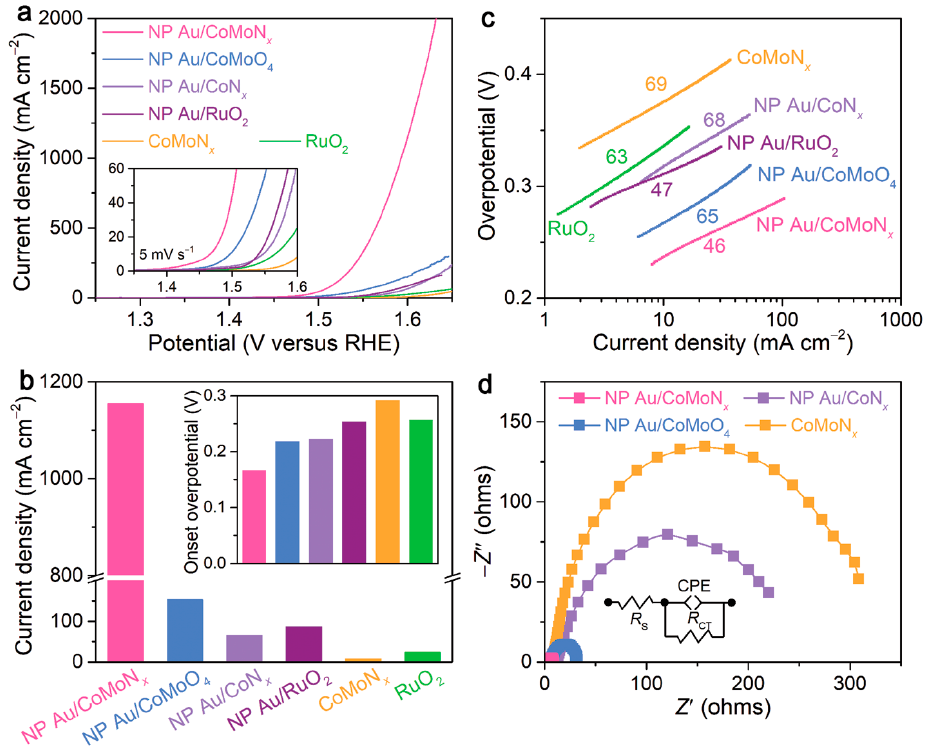
Figure 4. OER activity of bimetallic cobalt-molybdenum nitride nanosheets vertically aligned on NP-Au electrodes in alkaline media. ( a ) OER polarization curves of NP-Au/CoMoN x , Au/CoMoO 4 , Au/CoN x and Au/RuO 2 , as well as free CoMoN x nanosheets and RuO 2 immobilized on a GC electrode at 5 mV s − 1 in 1 M KOH. Inset: Expanded view of the lowoverpotential region in panel ( b ). Comparison of the current densities at the overpotential of 0.37 V for the electrodes shown in panel (a). Inset: The onset overpotentials of these different electrocatalysts for the OER. ( c ) Tafel plots comparing the Tafel slopes of different catalysts obtained from the polarization curves in panel ( a ). ( d ) EIS spectra of electrodes shown in panel ( a ). Copyright 2020 by John Wiley and Sons [38].